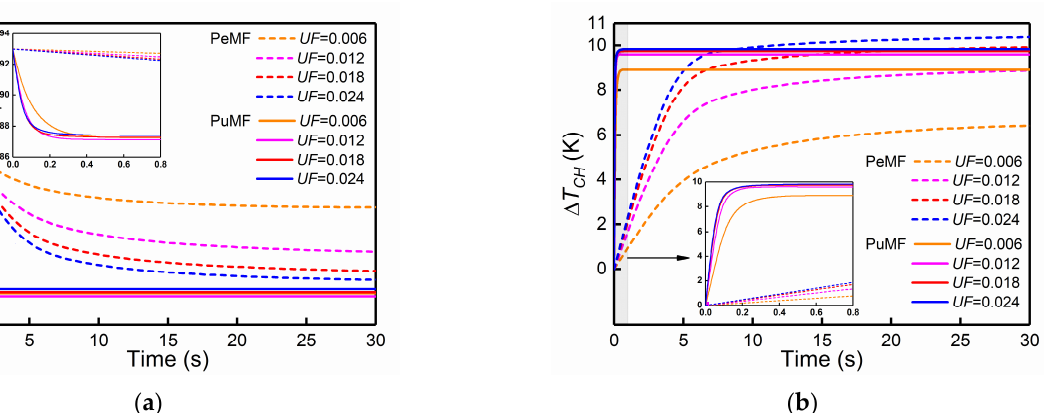
Figure 6. Transient variations of the cold ‐ end temperature T s,c and temperature difference Δ T CH un ‐ der different UFs ( H = 1 T, Q ̇ c = 0 W, T h = T i = 293 K) ( a ) Cold ‐ end temperature; ( b ) yemperature difference.